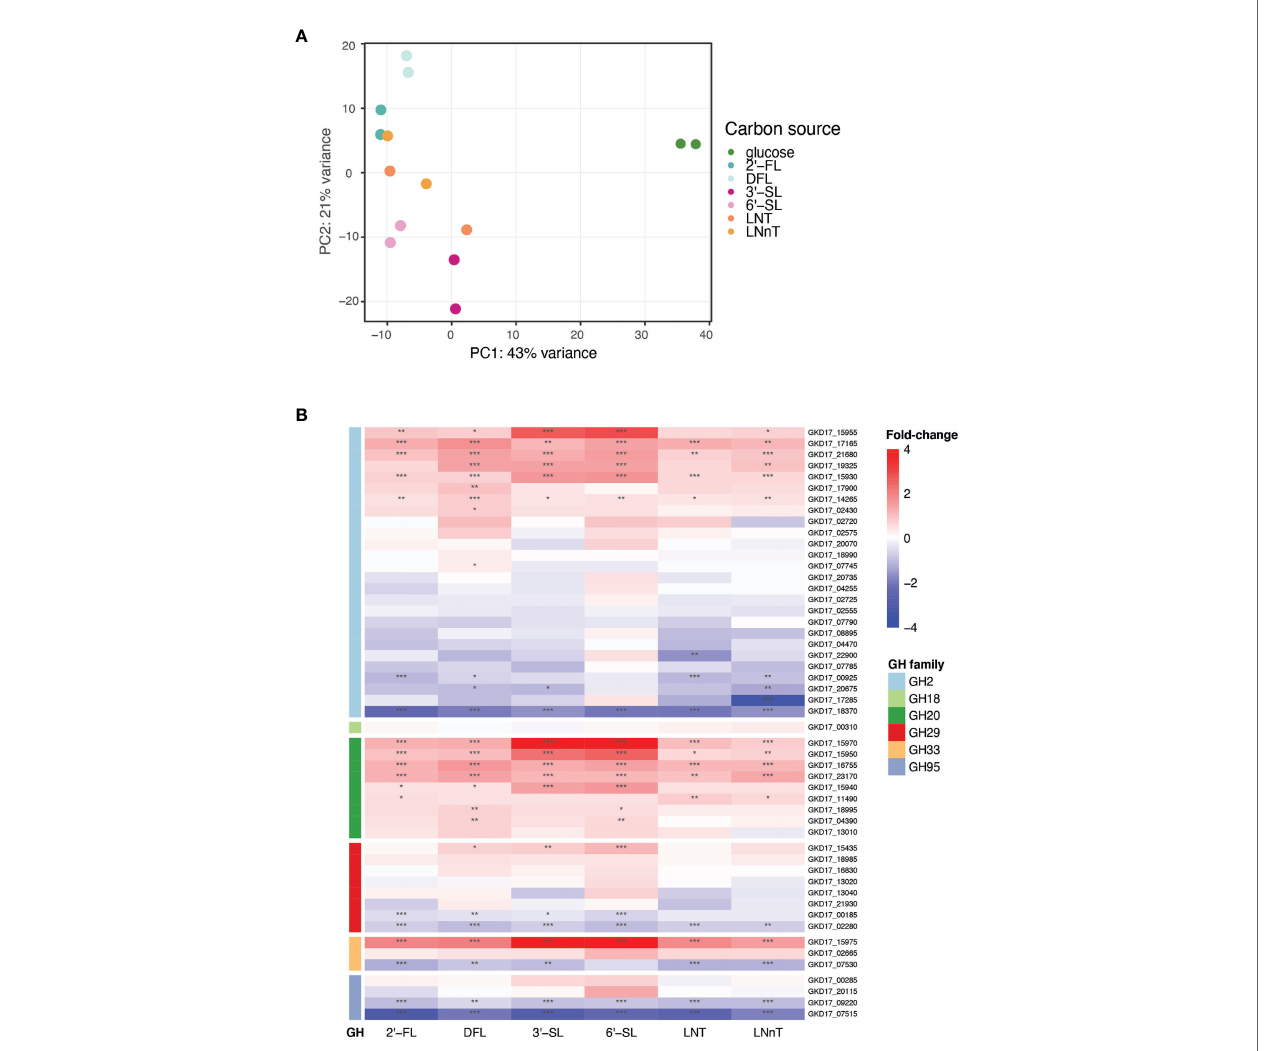
FIGURE 3 | B. dorei ’ s transcriptional response to HMOs is similar across conditions. (A) Principal Component Analysis (PCA) of transcriptional pro fi les of pure cultures of B. dorei on various carbon sources, in two biological replicates, using RNA-Sequencing (Methods). (B) Heat map of log2 fold-change of genes (rows) belonging to glycoside hydrolase (GH) families previously known to break down HMOs. Gene expression data on HMOs (2 ’ -FL, DFL, 3 ’ -SL, 6 ’ -SL, LNT, LNnT; columns) was compared to gene expression on glucose. p < 0.05 (*); p < 0.01 (**); p < 0.001